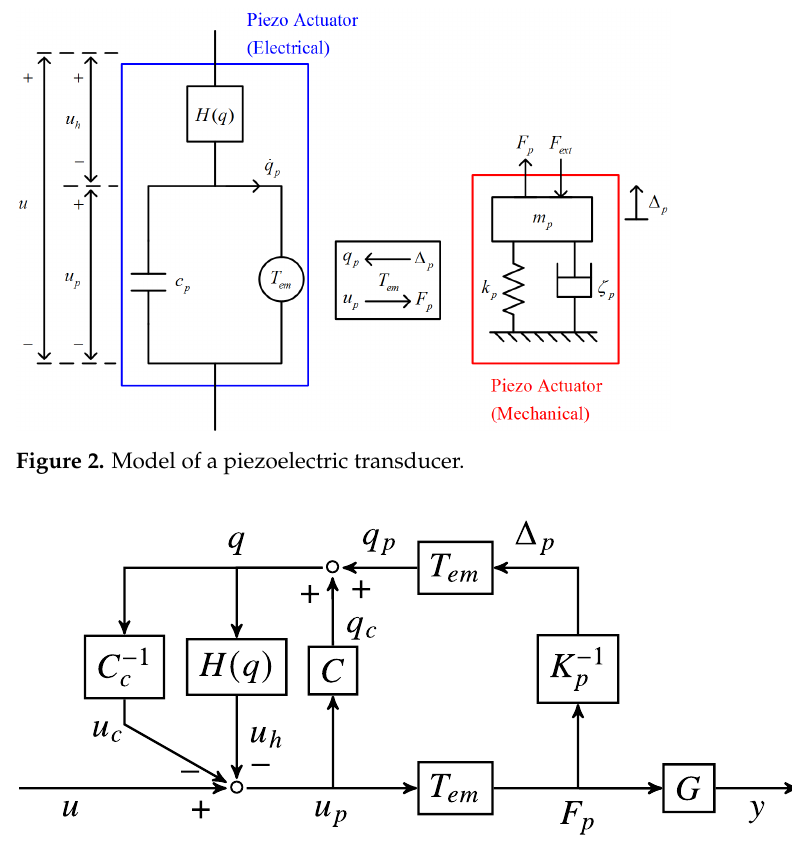
Figure 3. Block diagram of a piezo-actuated stage